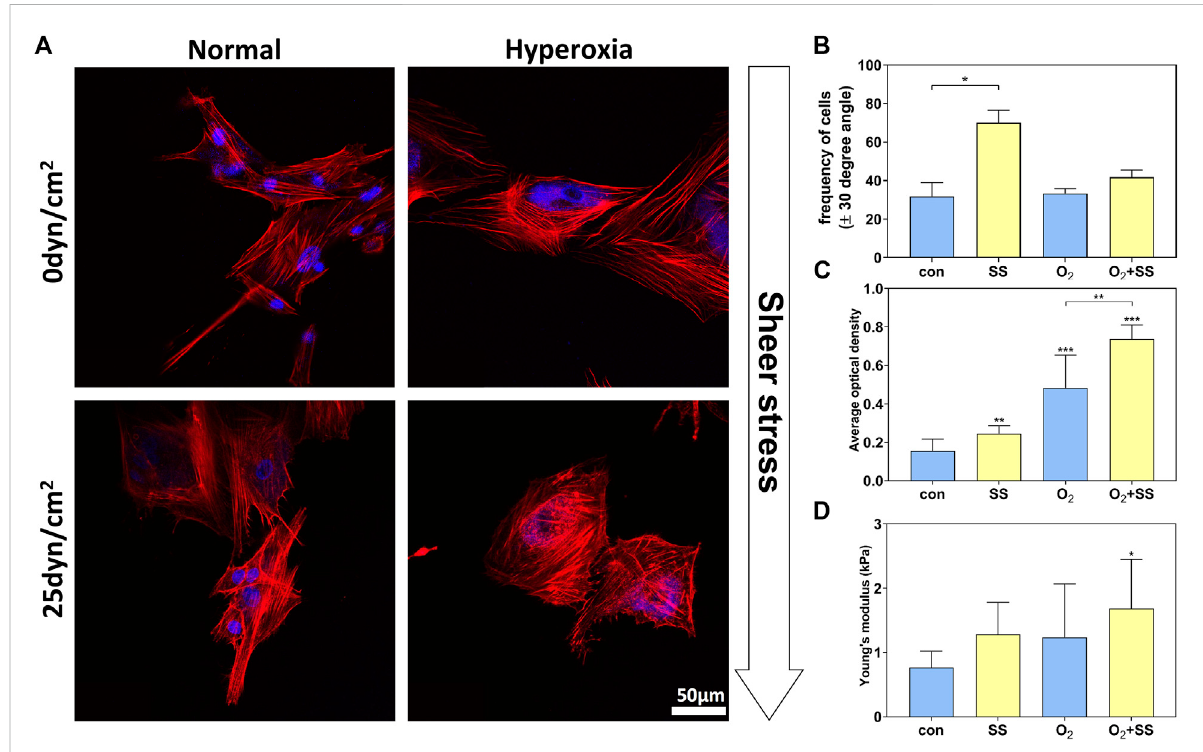
FIGURE 2 Effect of senescence on cytoskeleton and cell stiffness of PTM cells in response to shear stress. (A) Fluorescence images of normal and senescentPTMcellsunderstaticconditions(noshearstress)orsubjectedtoshearstressof25 dyn/cm 2 .Red:phalloidin,Blue:DAPI. (B) Alignmentof thecytoskeletonofnormalandsenescentPTMcellsunderstaticconditionsorsubjectedtoshearstress(* p < 0.05). (C) F-actincontentofnormaland senescent PTM cells under static conditions or subjected to shear stress (** p < 0.01, *** p < 0.001). (D) Cell stiffness of normal and senescent PTM cells under static conditions or subjected to shear stress (* p < 0.05). SS stands for shear